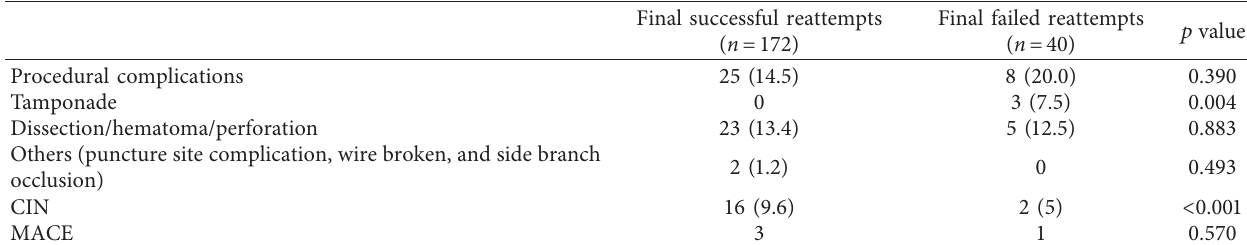
Table 5: Complications between final successful and failed reattempted